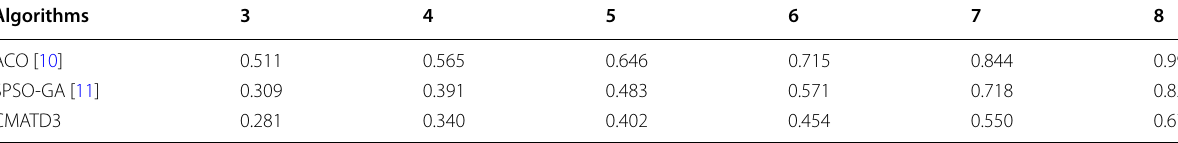
Table 1 Performance comparation with different number of IoT devices